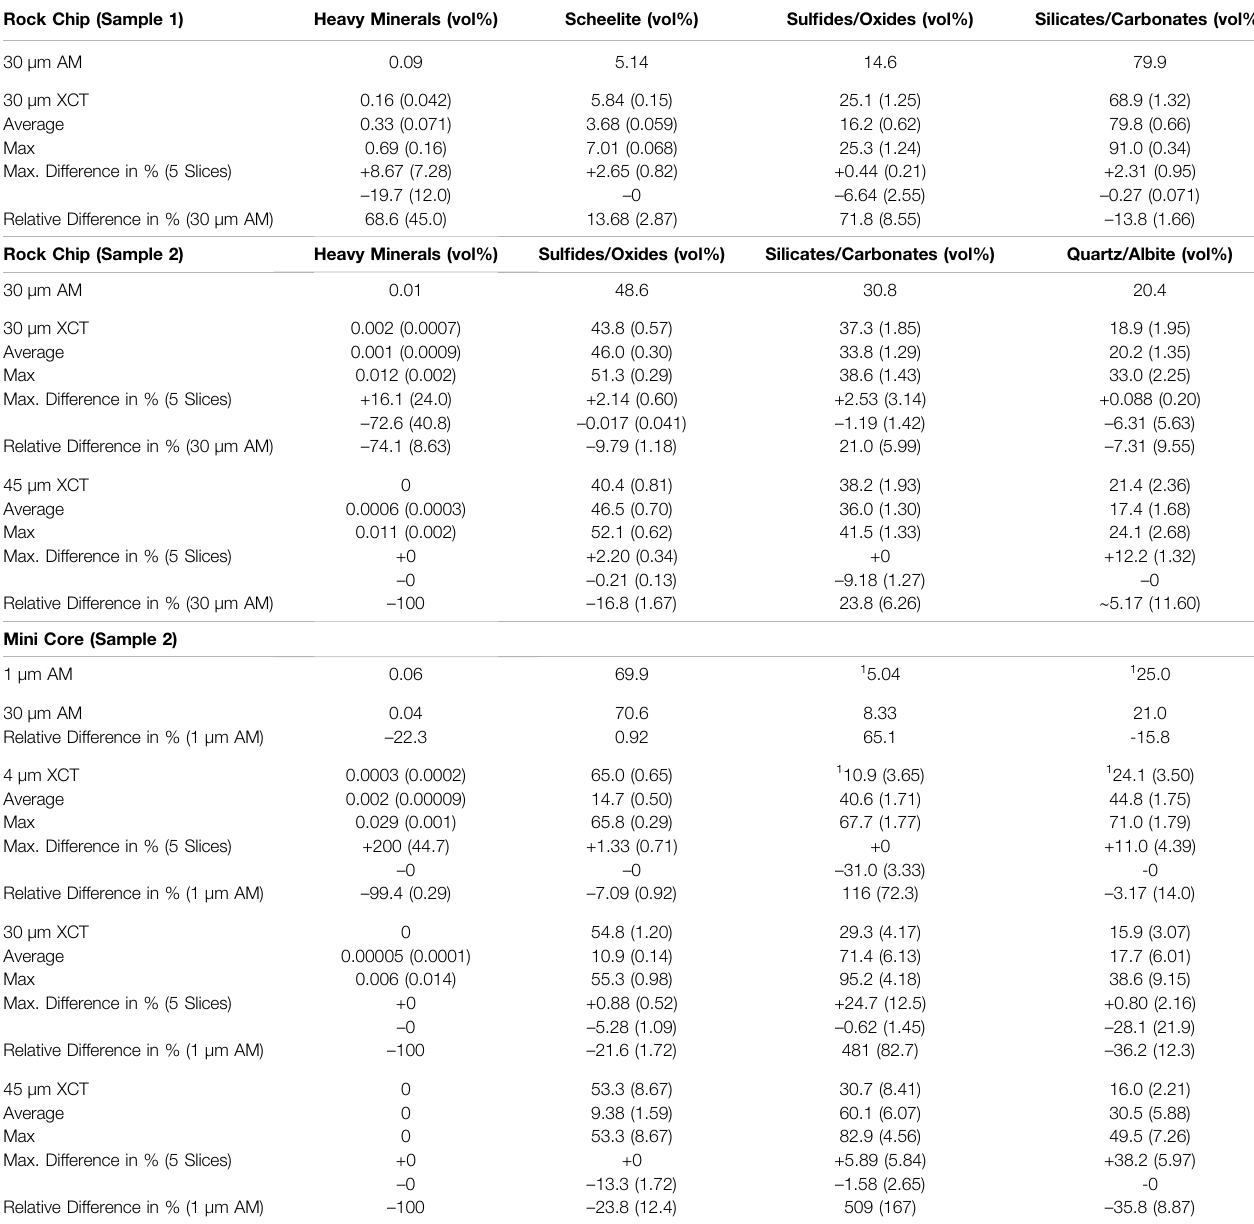
TABLE 3 | Comparison of the area fraction of the classes segmented in the rock chip of samples 1 and 2 between the AM mineral map and the corresponding XCT slice. Additionally, the maximal difference in percent between the XCT slice used for comparison with AM and the following four slices is shown. Average and Max values refer toallsliceswithinaspeci fi csegmentedvolume(rockchip,minicore)ofanXCTdataset.TheXCTvaluesarethemeanvaluesofsixsegmentations( n (cid:2) 6)ofthesamevolume, withthestandarddeviationinbrackets.Aminimalerror( < 0.2area%)mayoccurforthe1 μ mAMdataofsample2dueto fi lecorruption(seesectionAutomatedMineralogy). Rock Chip (Sample